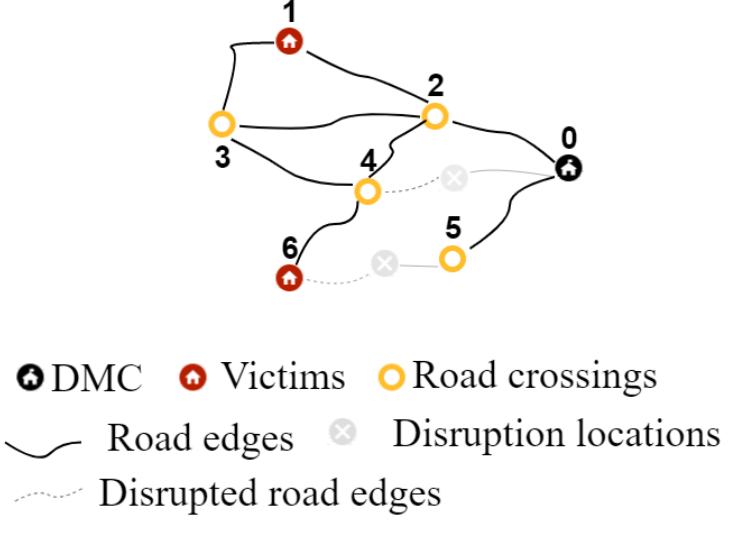
Figure 2. Disrupted network.